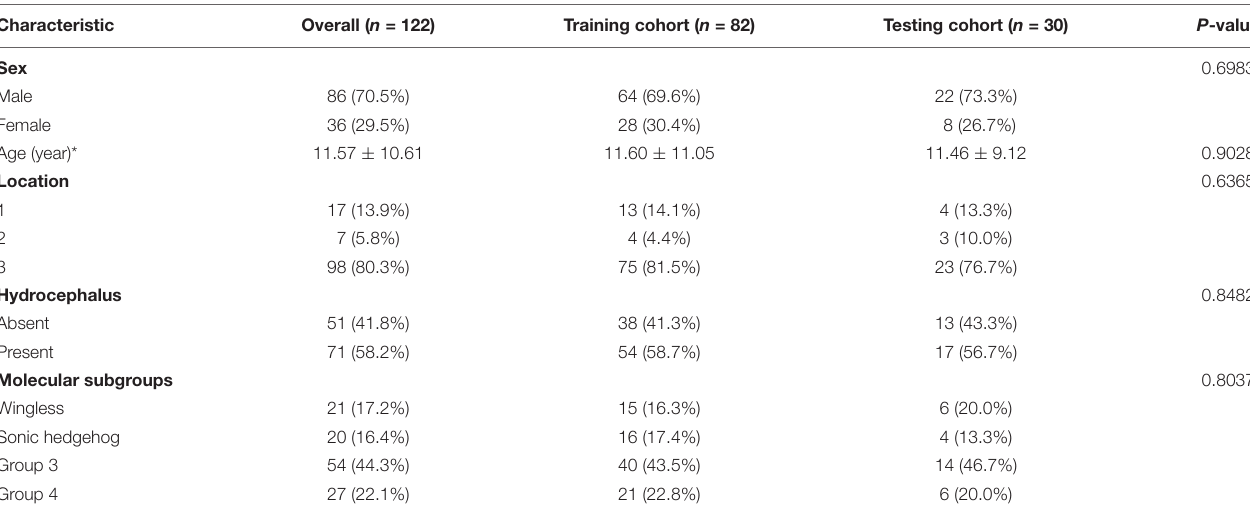
FIGURE 1 | Overview of the radiomics pipeline in this study. The pipeline consisted of tumor delineation, image preprocessing, radiomics feature extraction, feature selection, model building, and model evaluation. TABLE 1 | Characteristics of patients with medulloblastoma in the training cohort and testing